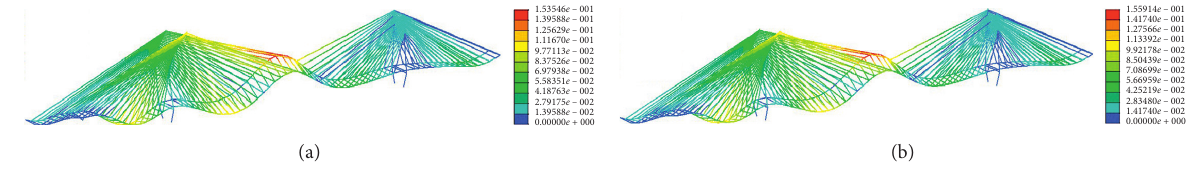
Figure 20: Displacement responses for the repair cases (unit: m): (a) repair scheme 1 and (b) repair scheme